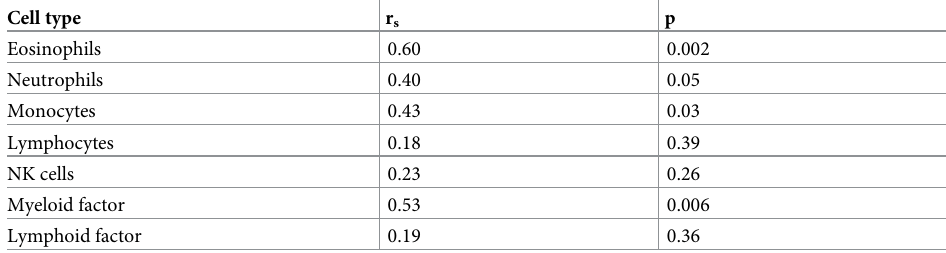
Table 1. Correlations between leukocyte CD41 positivity or principal component analysis (PCA) factors and PEC at V2. Cell